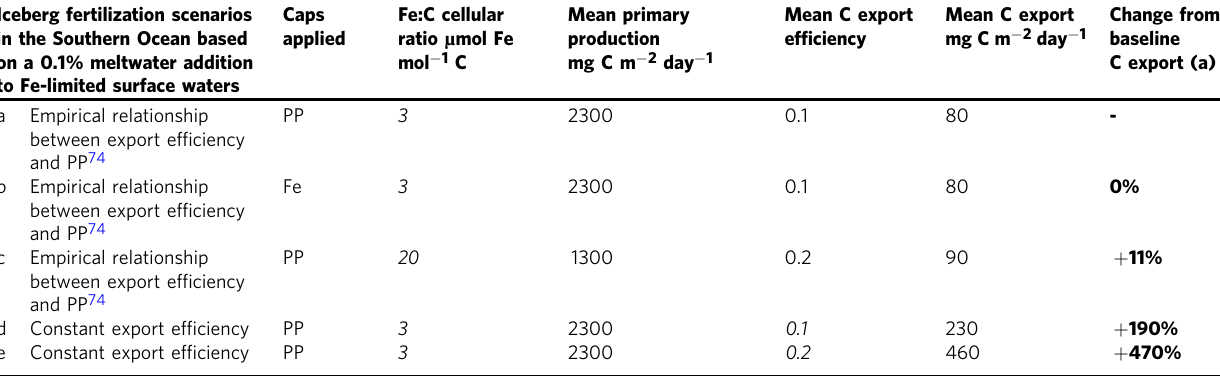
Table 1 Conversion between Fe, primary production (C) and C export, for a speci fi c scenario where a uniform mixed layer of 100 m is fertilized with a 0.1% meltwater enrichment for each iceberg in the global dataset Iceberg fertilization scenarios in the Southern Ocean based on a 0.1% meltwater addition to Fe-limited surface